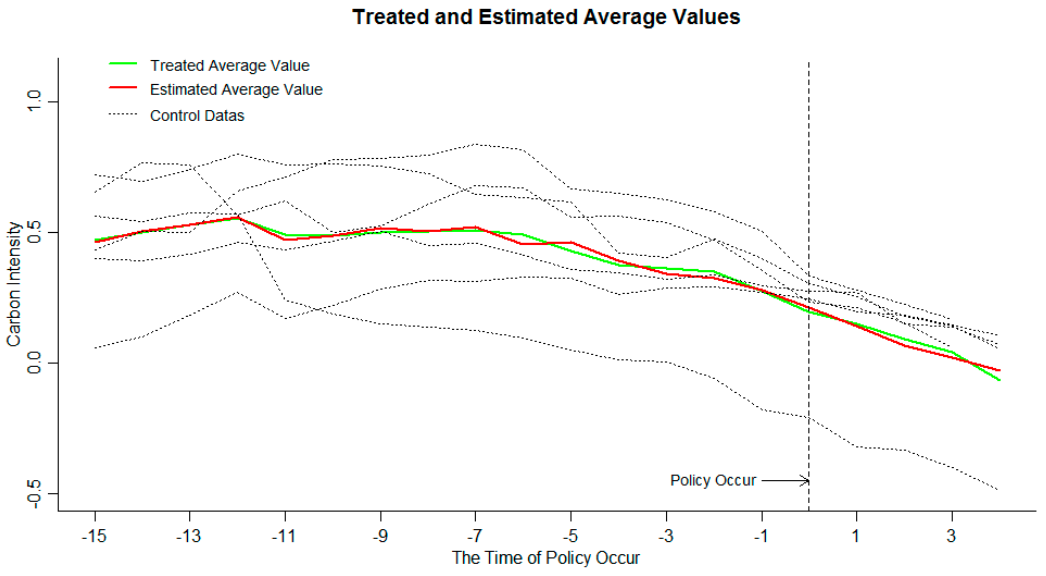
Figure 2. Treated values and estimated values carbon emission intensity of the target group.